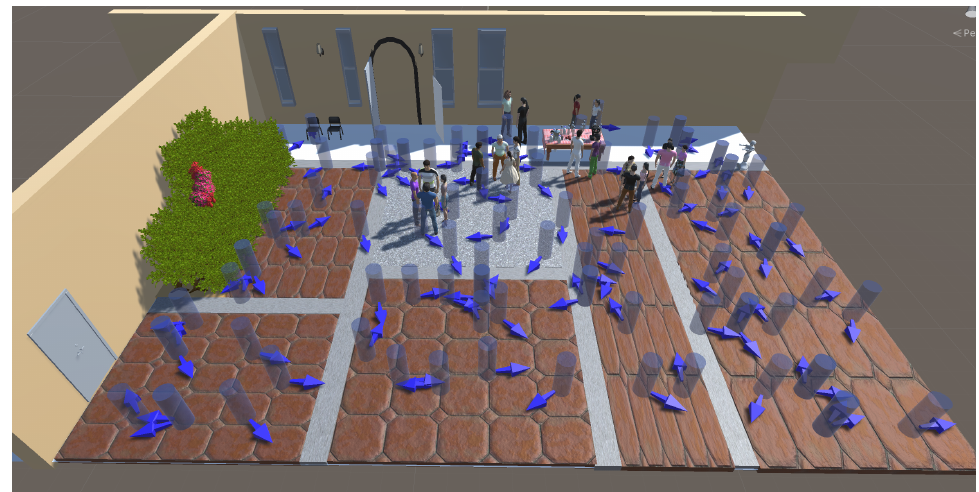
Figure 10. The global view of Scene 1 along with 100 randomly generated positions for the robot, which are represented by purple-coloured cylindrical spaces. The arrows represent the facing direction of the robot for respective position (best viewed in colour).